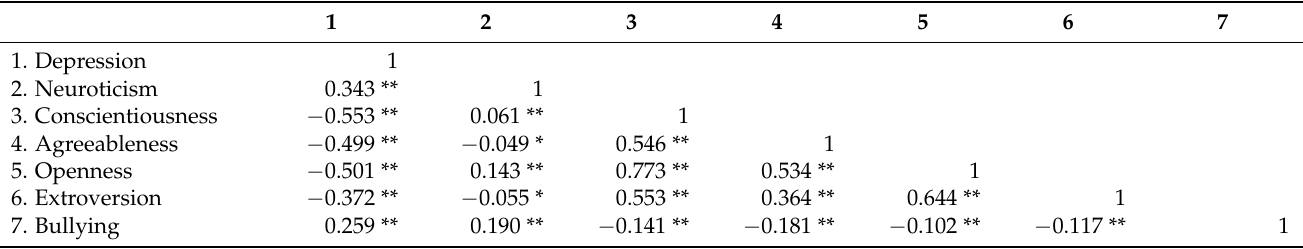
Table 3. Correlation Analysis of Variables ( r ).